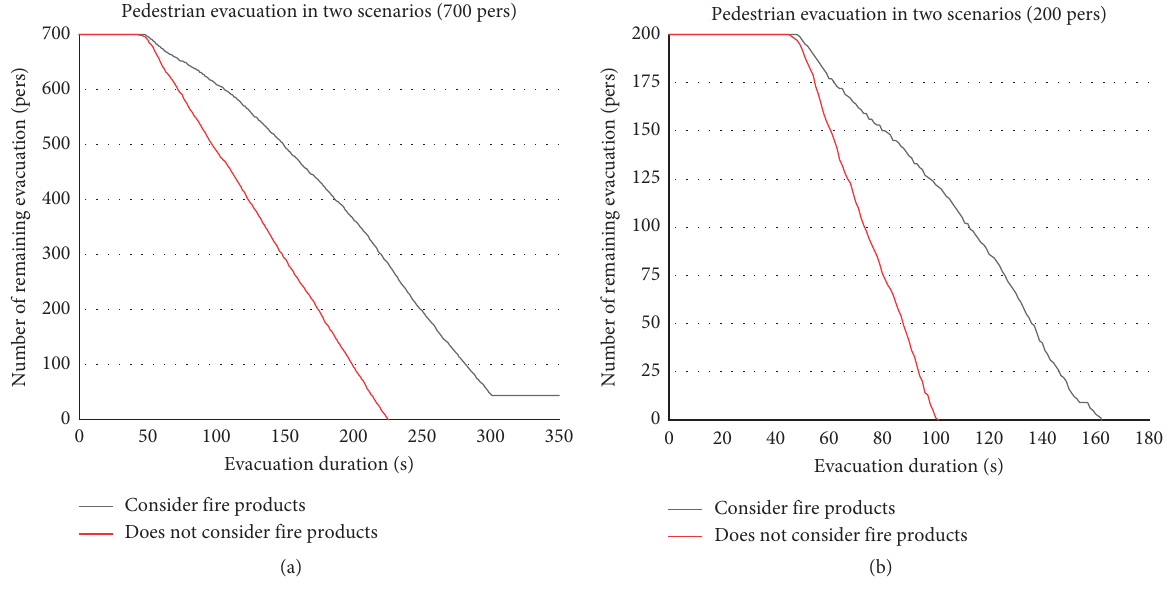
Figure 10: Comparison of pedestrian evacuation in different